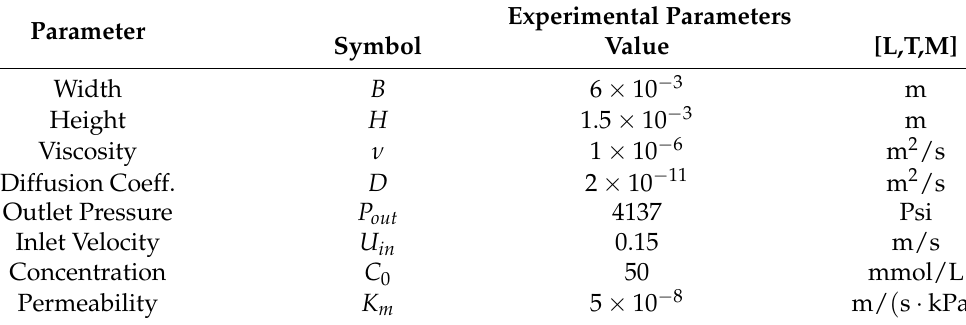
Table 2. Experimental parameters, symbols, values, and corresponding units.